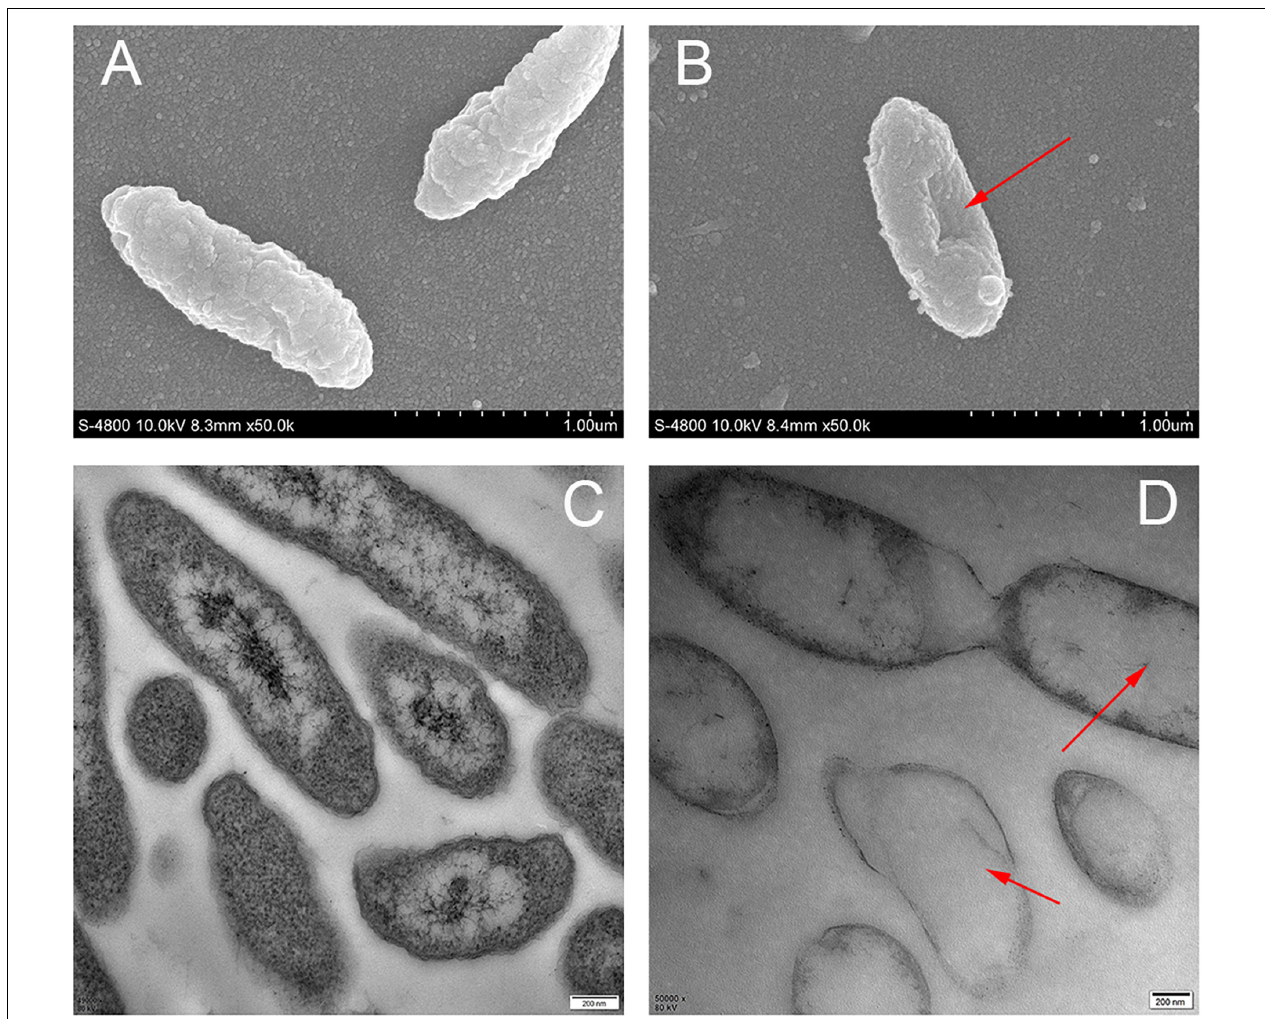
FIGURE 4 | Images of scanning electron microscopy (A,B) and transmission electron microscopy (C,D) of S. maltophilia 4–1 before (A,C) and after (B,D) cinnamic acid